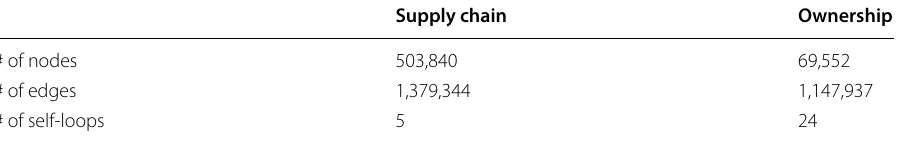
Table 2 The numbers of nodes, edges, and self-loops in supply chain and ownership data Supply chain Ownership # of nodes 503,840 69,552 # of edges 1,379,344 1,147,937 # of self-loops 5